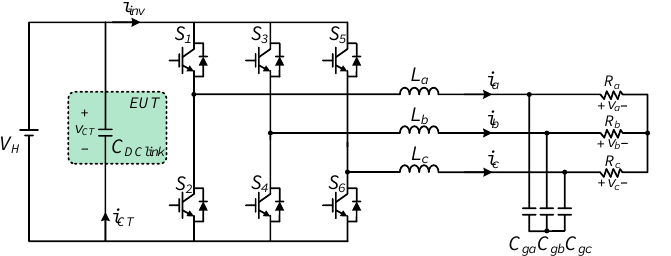
Figure 1. Full-scale voltage rating evaluation system in a high-power three-phase inverter.